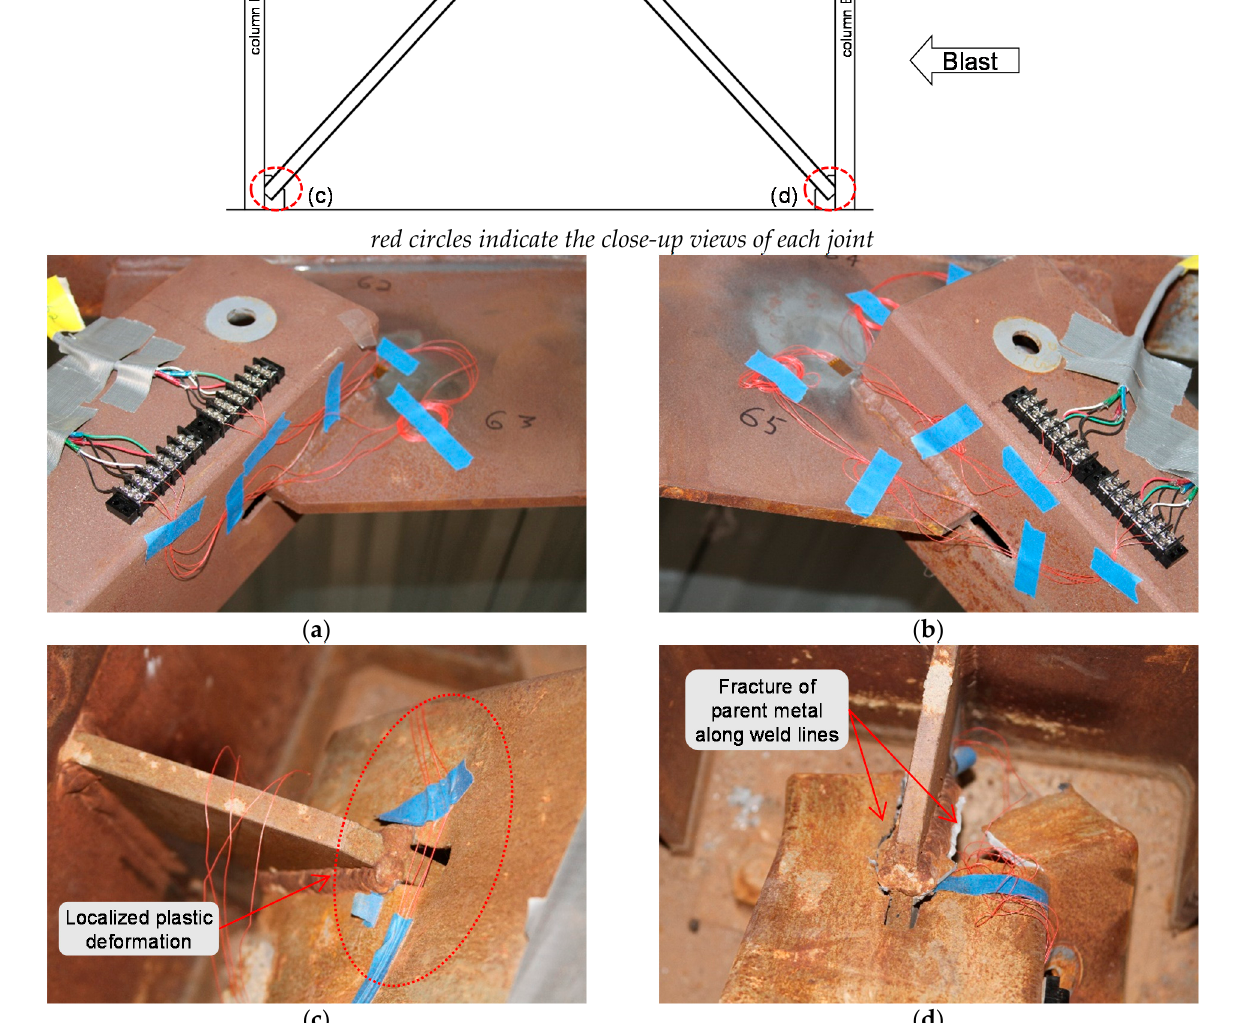
Figure 17. Test 2—First floor brace connections at column line B: ( a ) Top gusset joint closer to column B3; ( b ) Top gusset joint closer to column B2; ( c ) Base gusset joint with column B3; ( d ) Base gusset joint with column B2.